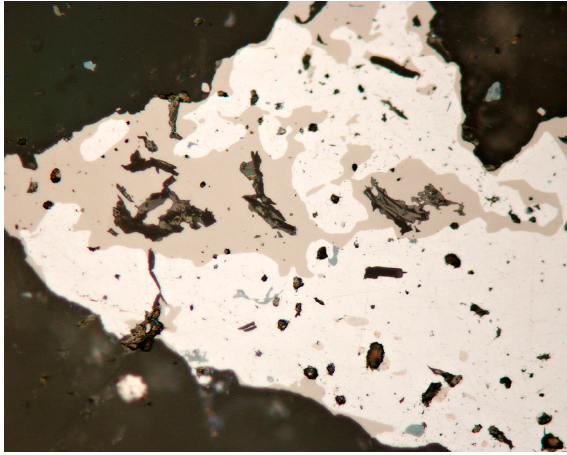
Figure 21. Dark grey euhedral crystals of cadmoselite in tiny cavities of a light brownish aggregate of Cd-hakite overgrowing by light clausthalite. Reflected light, one polarizer. FOV is 210 μ m. P ř íbram, a dump of the shaft 16. Photo by P. Škácha.